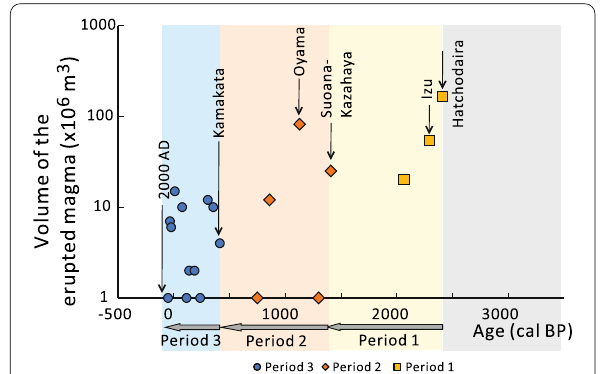
Fig. 11 Volume of erupted magmas plotted against their eruption age. Types of symbols indicate the magmatic periods defined in the text. Note that the volume of the lavas filling the Hatchodaira caldera during Period 1 (~ 6 10 –1 km 3 ) is not shown in this ×